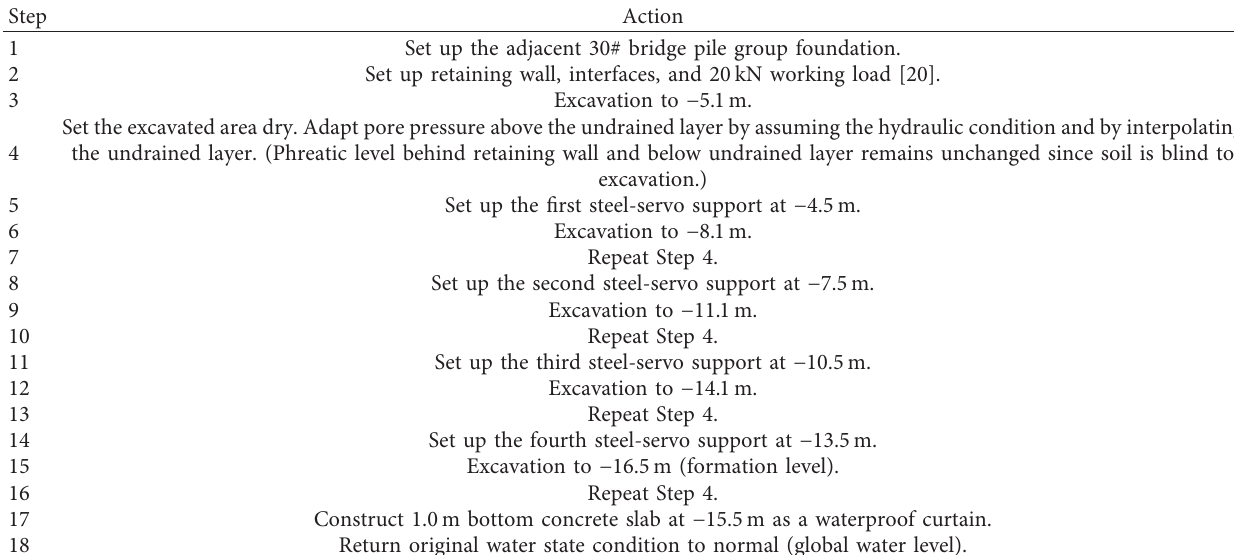
Table 4: Numerical modelling steps.